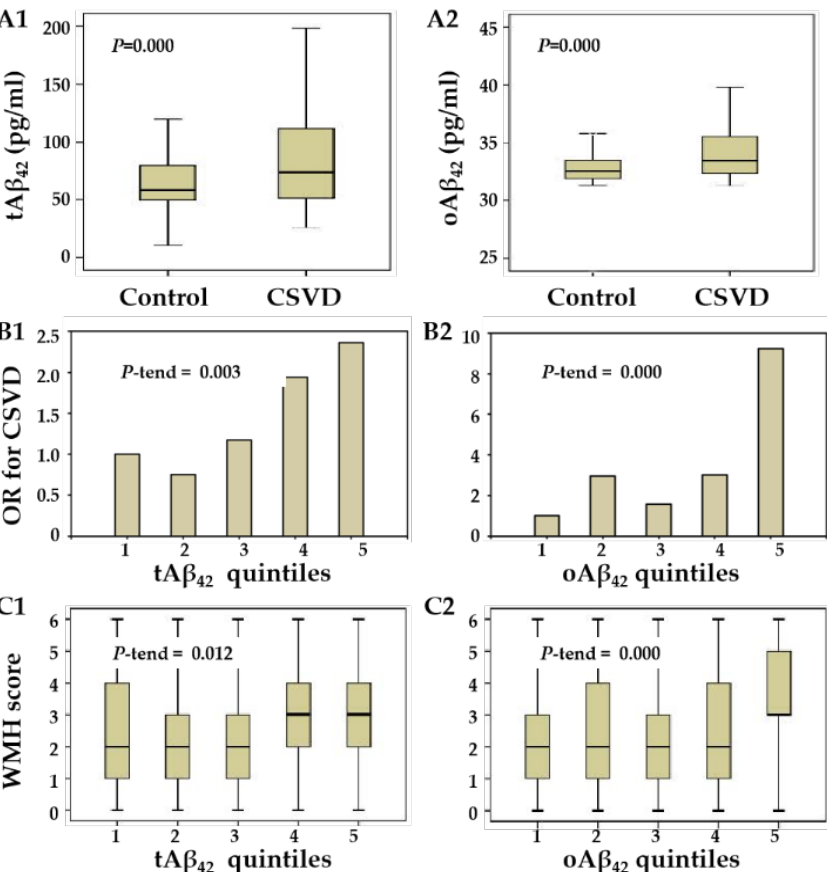
Figure 3. Plasma A β 42 levels and the correlations with CSVD/WMH presence. Relative to that in the control group, either the tA β 42 ( A1 ) or oA β 42 ( A2 ) level was elevated in the CSVD group. Correlations between the presence of CSVD and t/oA β 42 quintiles were analyzed by logistic regression analyses after adjustment for age and sex. P -trends for continuous linear trend per stratum were calculated by Mantel–Haenszel chi-square tests and are displayed in the upper left corners. ORs of quintiles for CSVD are presented in ( B1 , B2 ); Grouped by t/oA β 42 quintiles, WMH scores are displayed in Box-and-whisker plots ( C1 , C2 ).